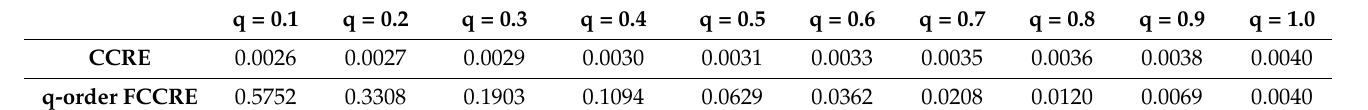
Table 1. The specific values of q-order FCCRE and q power of CCRE.